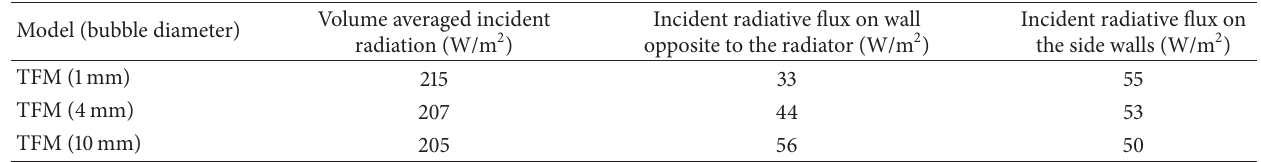
Table 4: Sensitivity of radiative transfer predictions to the initial bubble diameter.